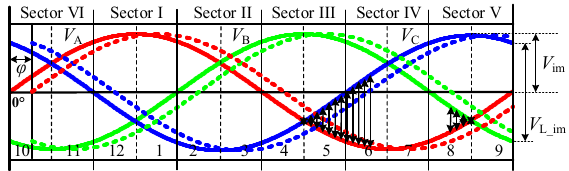
Figure 9. Voltage stress of S 21 with the compensation angle φ .